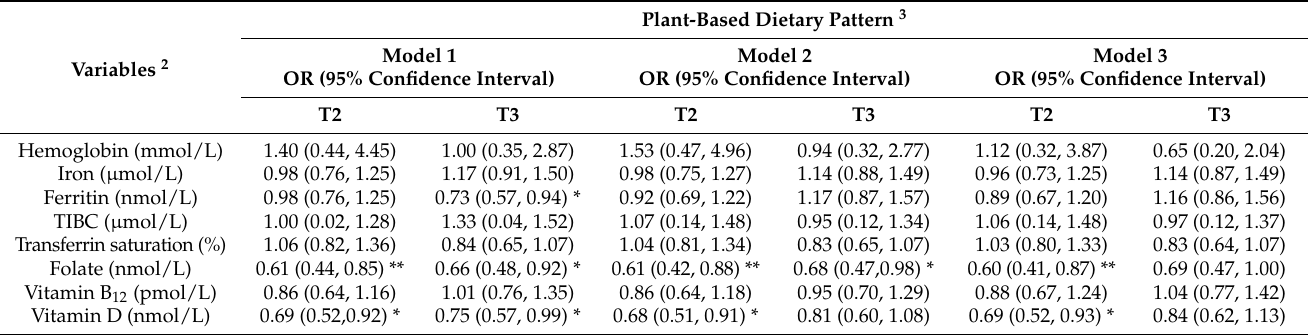
Table 6. Odds ratios (ORs) of low-anemia-related biochemical variables in serum across the tertiles of plant-based dietary pattern assessed by binomial logistic regression analysis 1 .